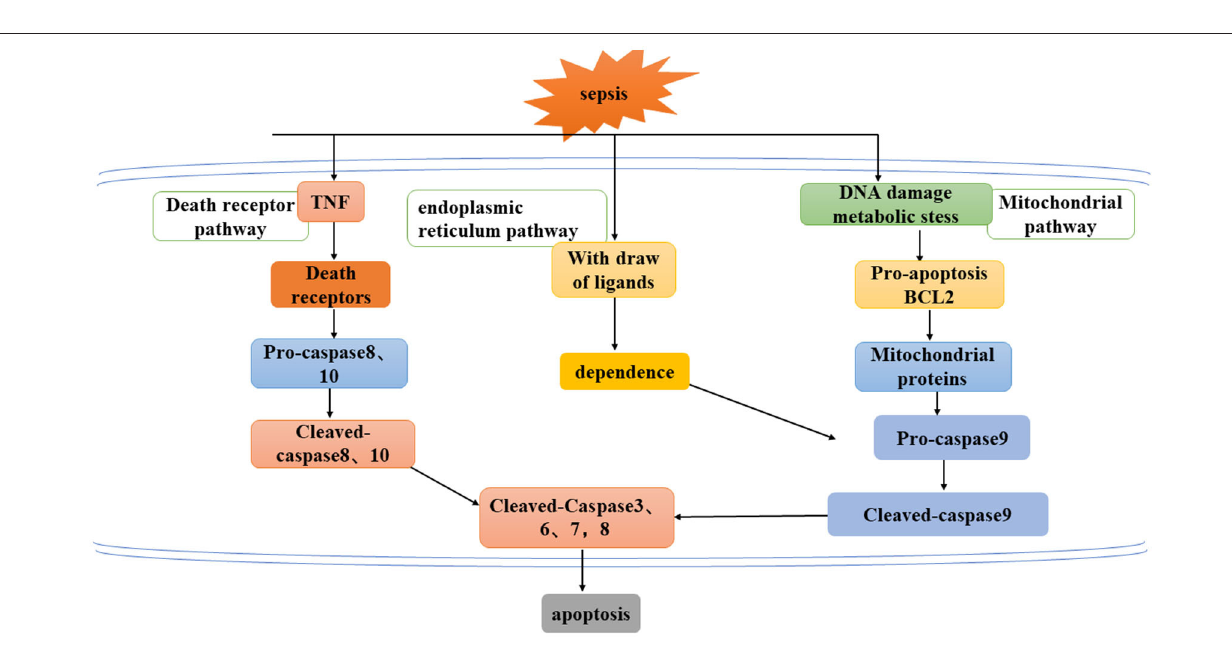
pathological damage between human patients and animals; (2) human specimens are collected after the patients’ death, and blood circulation stops after the patient’s death, leading to rapid organ death (42,